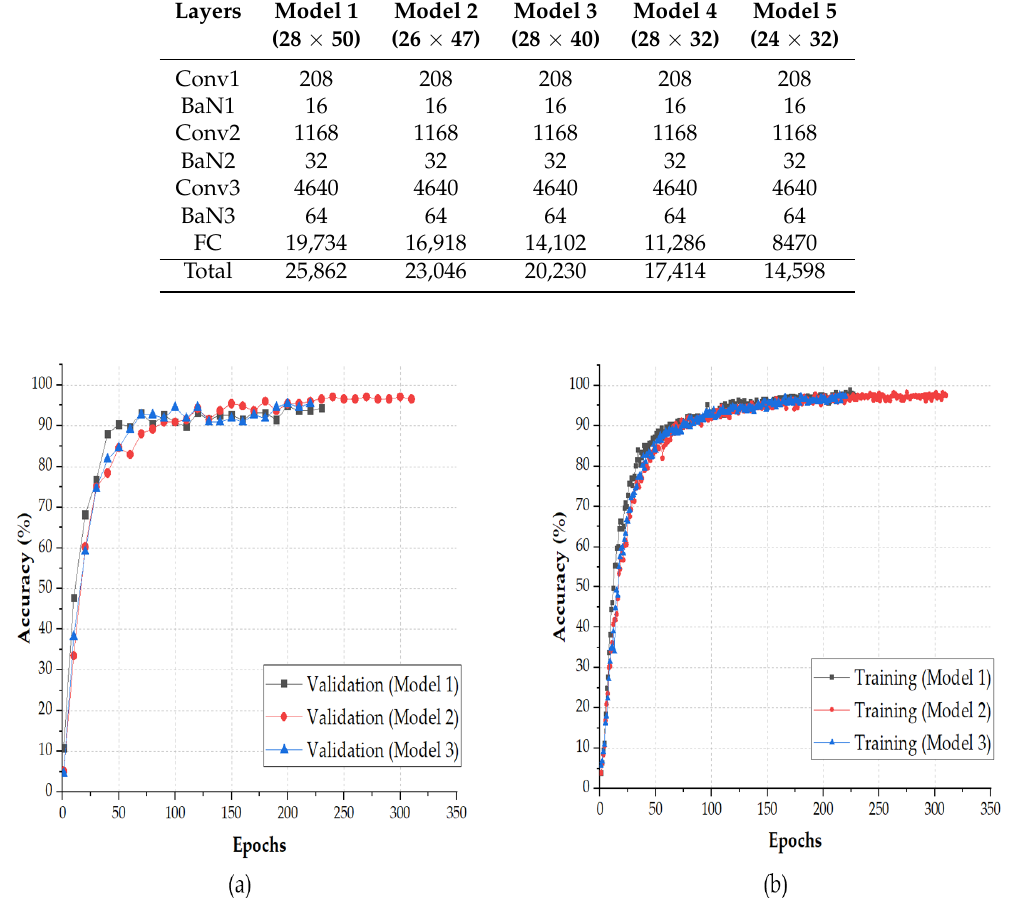
Figure 6. Learning accuracy for the 3 configurations of the TactNet4model: ( a ) training; ( b )